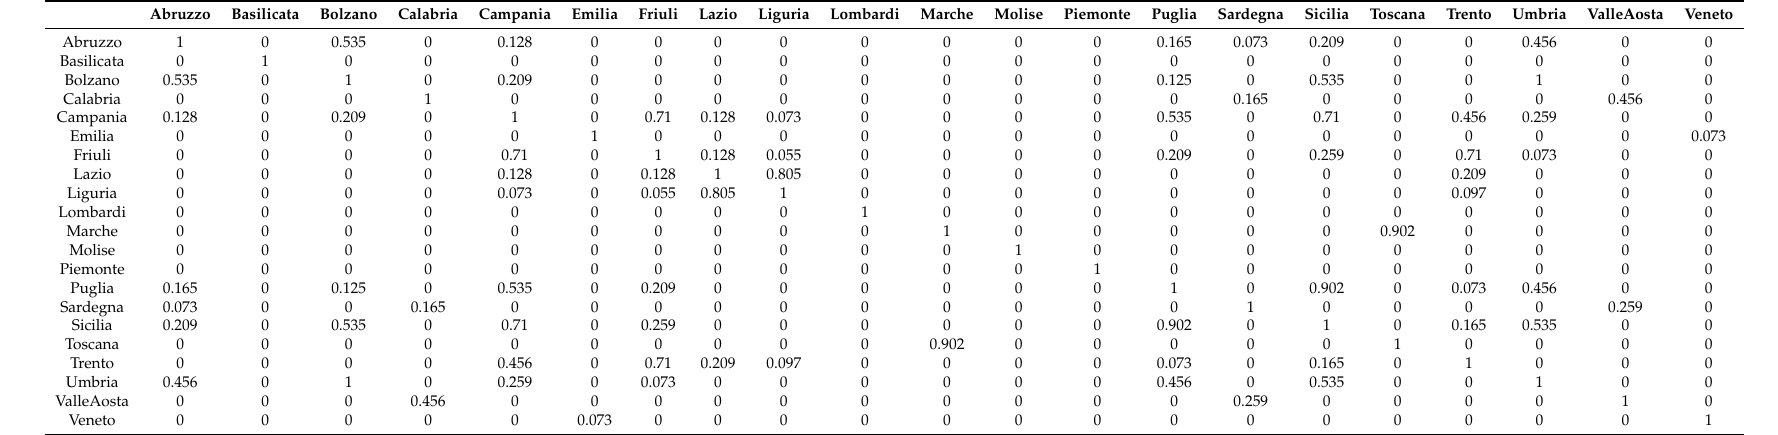
Table A24. Similarity values of Home Isolation network in the fifth